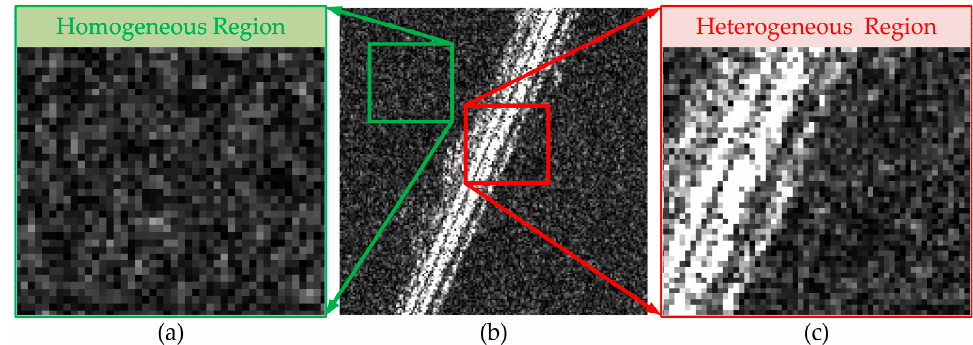
Figure 1. Homogeneous and heterogeneous regions. ( a , c ) are the local enlarged images of ( b ) original SAR image.